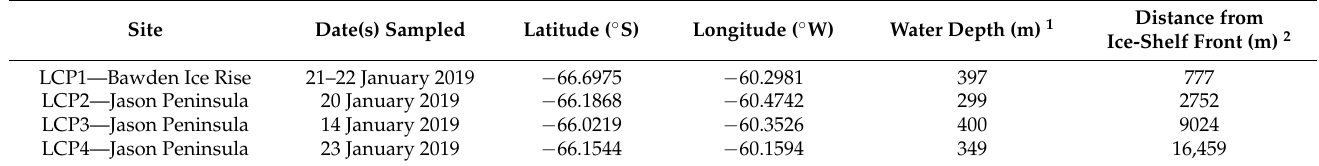
Table 1. Western Weddell Sea continental shelf study sites, LCP1-4, investigated for benthic megafau- nal assemblages, including date(s) sampled (seafloor imagery collection), position in decimal degrees latitude ( ◦ S) and longitude ( ◦ W), and water depth (m) (all means across associated seafloor imagery), and distance from the ice-shelf front at the time of sampling